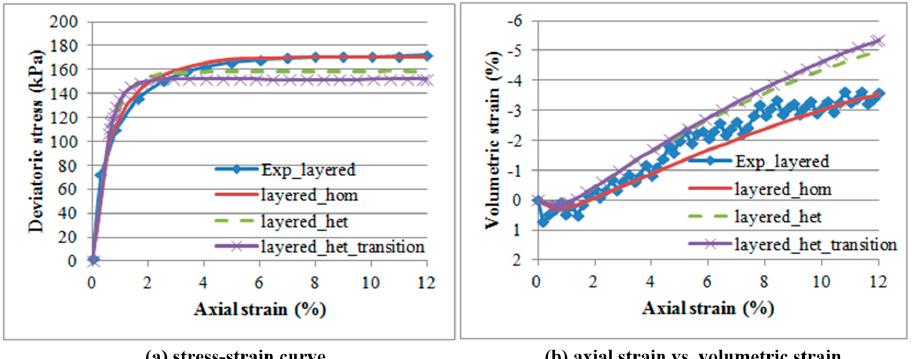
Figure 13. Model predictions in global behavior for layered specimen.